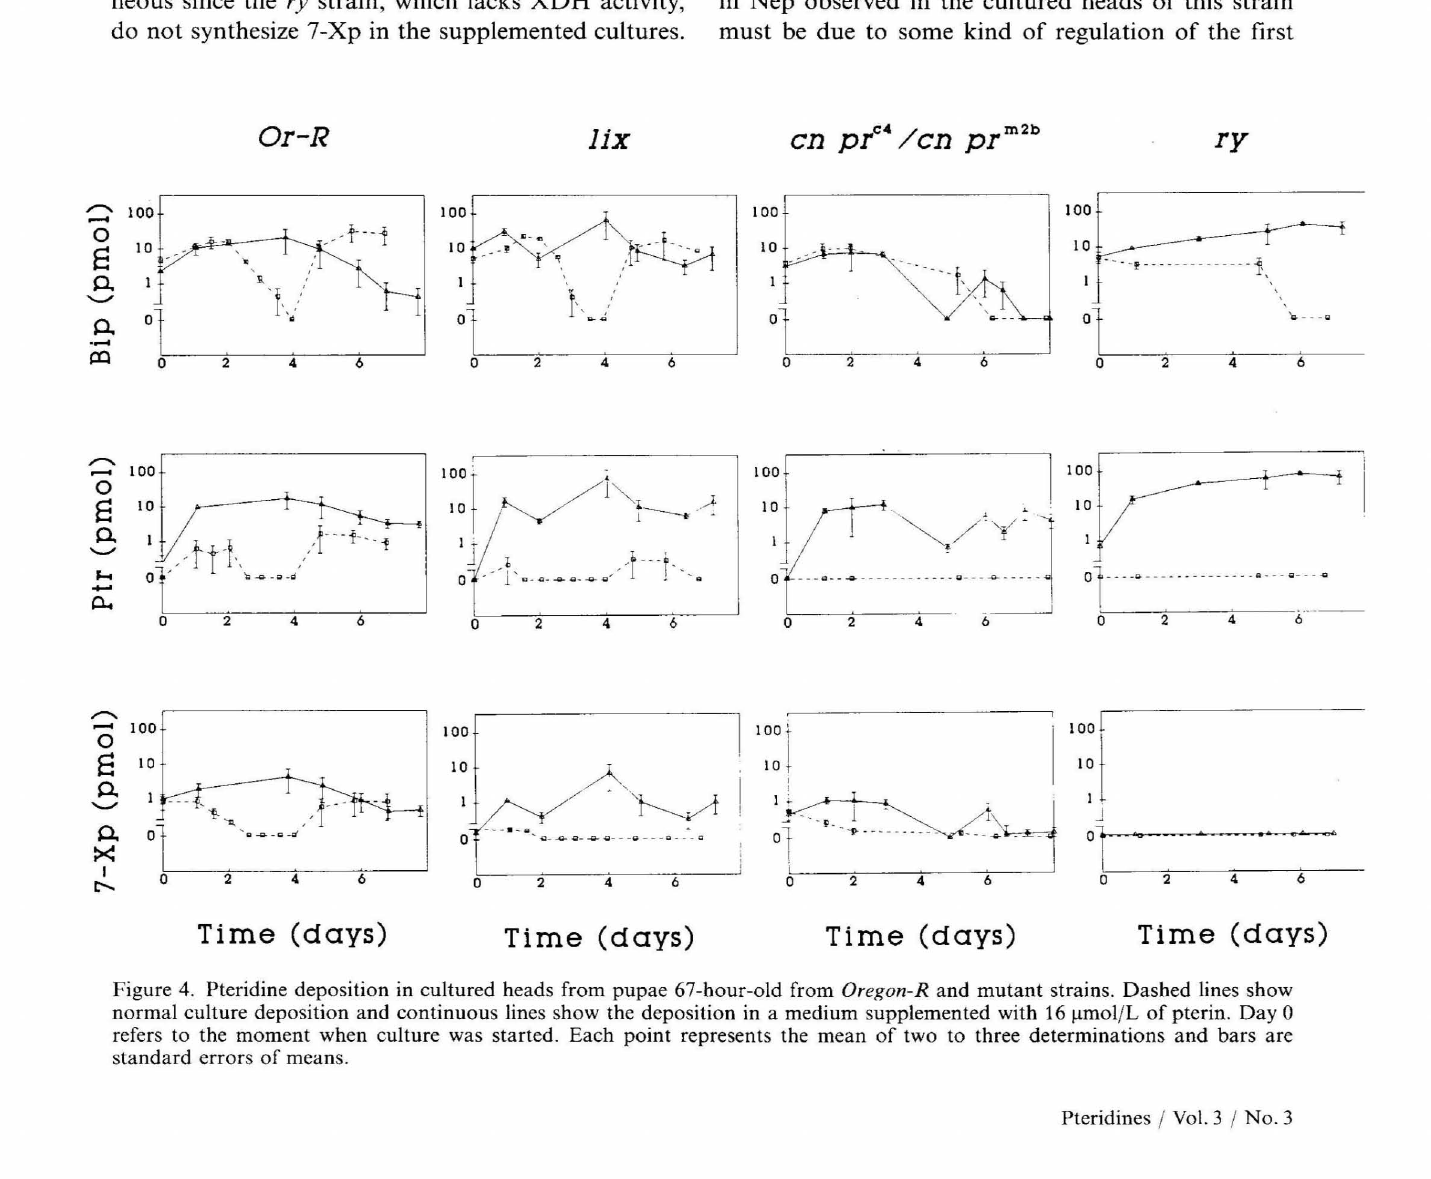
Pteridines ( VoL 3 /